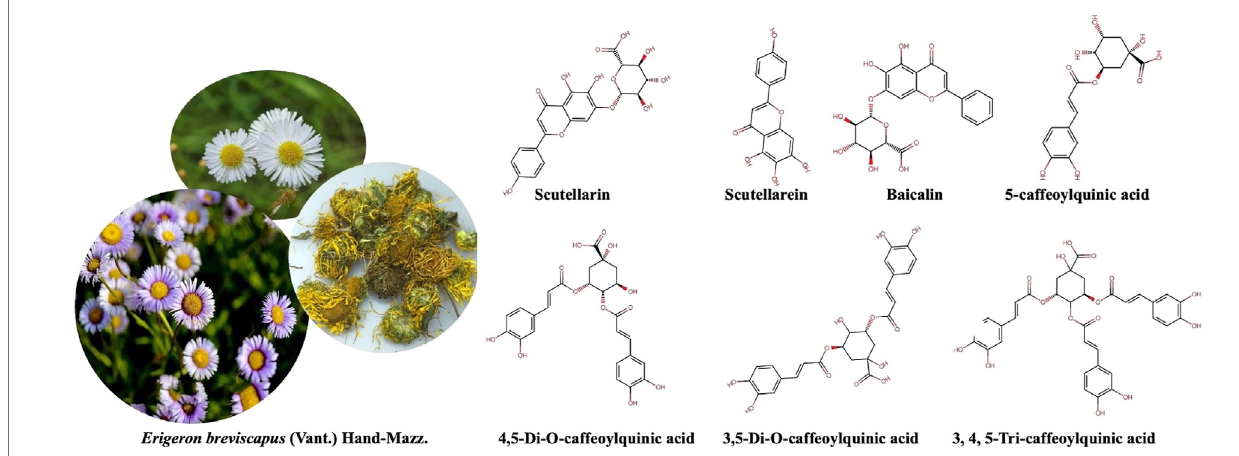
FIGURE 1 | The fl ower and main chemical structures of Erigeron breviscapus (Vant.) Hand-Mazz.